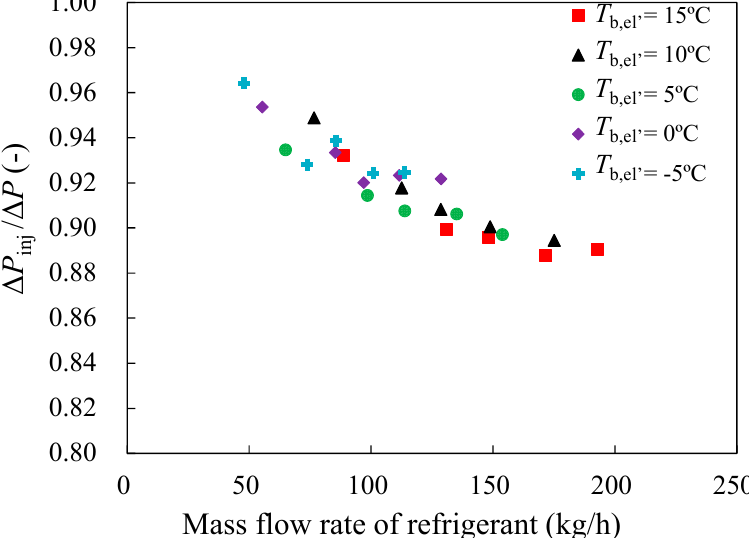
Figure 18. The injection pressure P inj with the change of injection ratio R in the vapor injection heat pump cycle.